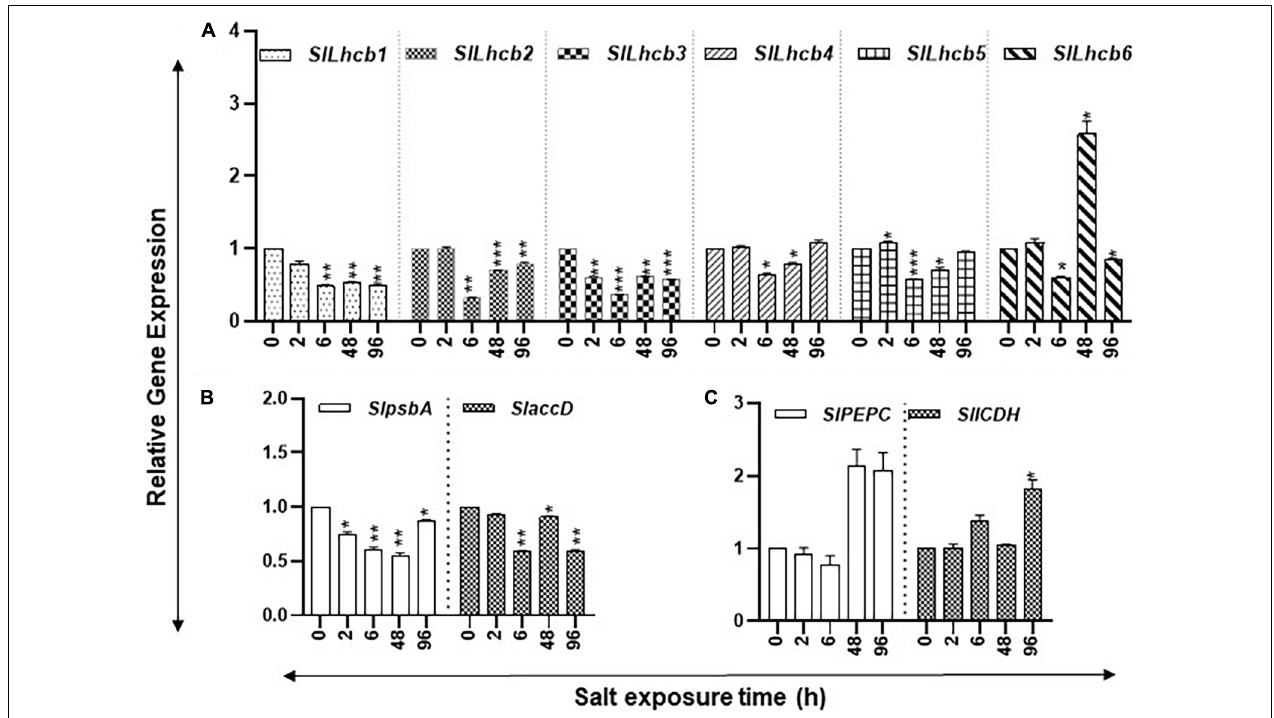
FIGURE 7 | Salt stress and abundance of chlorophyll a/b-binding, photosystem II (PSII), and carbon flow gene transcripts of tomato leaves. Quantitative PCR was used to determine the steady state levels of transcripts of (A) nuclear-encoded light-harvesting chlorophyll a/b-binding protein genes ( Lhcb1-6 ); (B) Plastid-encoded photosystem II (PSII) genes ( psbA and accD) ; and (C) phosphoenolpyruvate carboxylase ( PEPC ) and isocitrate dehydrogenase ( ICDH ) genes. Other details were the same as in Figure 1 .